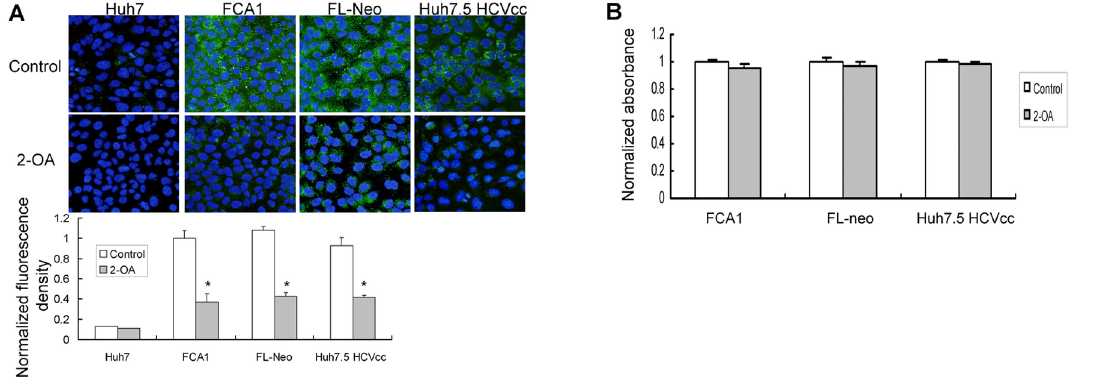
Figure 1. Effect of 2-OA on lipid accumulation in HCV replicon cells and infectious cell culture system. ( A ) Cellular lipid was evaluated in FCA1, FL-Neo cells and HCV-infected Huh7.5 cells (Huh7.5 HCVcc) in the presence of 100 m M 2-OA for 48 hours. Cells were stained for lipid content with BODIPY dye (green). DAPI was used for nuclear counterstaining (blue). Identical settings were maintained for image capture. Representative images are shown (upper). For quantification of lipid abundance, images were captured and analyzed using image analysis software. Values were normalized to control BODIPY levels (lower). ( B ) The effect of 2-OA on viability of FCA1, FL-Neo and Huh7.5 HCVcc cells was measured by MTS assay. The data were normalized with untreated